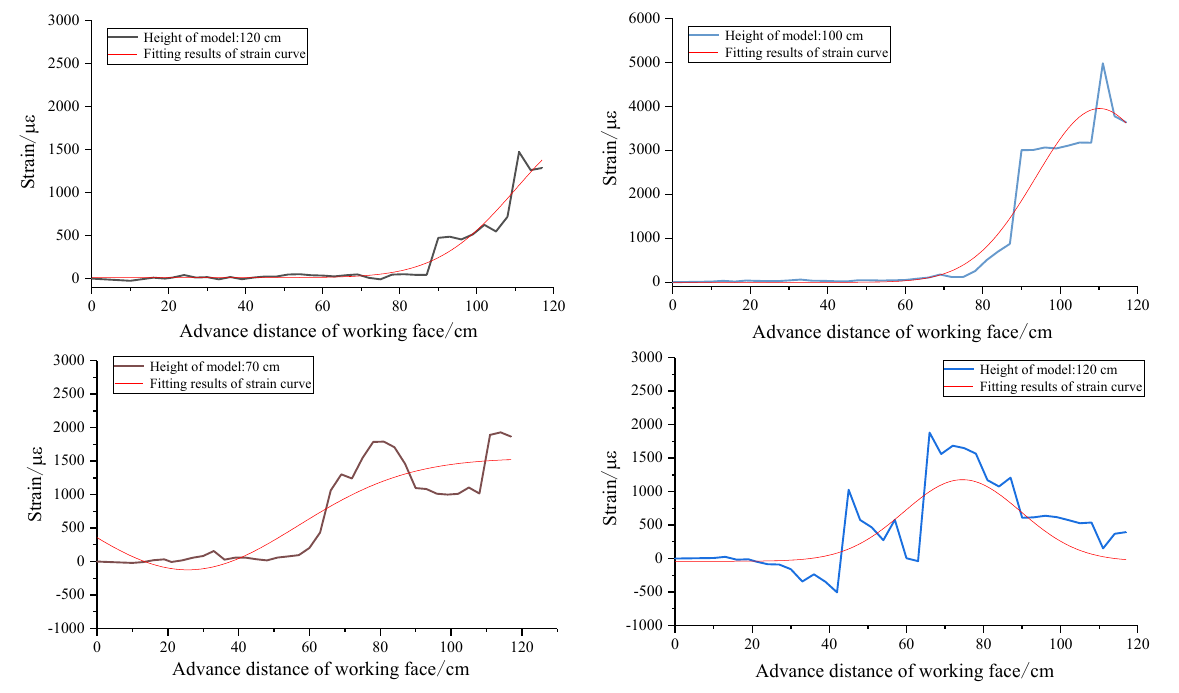
Figure 10. Strain fitting functions in different vertical zones.